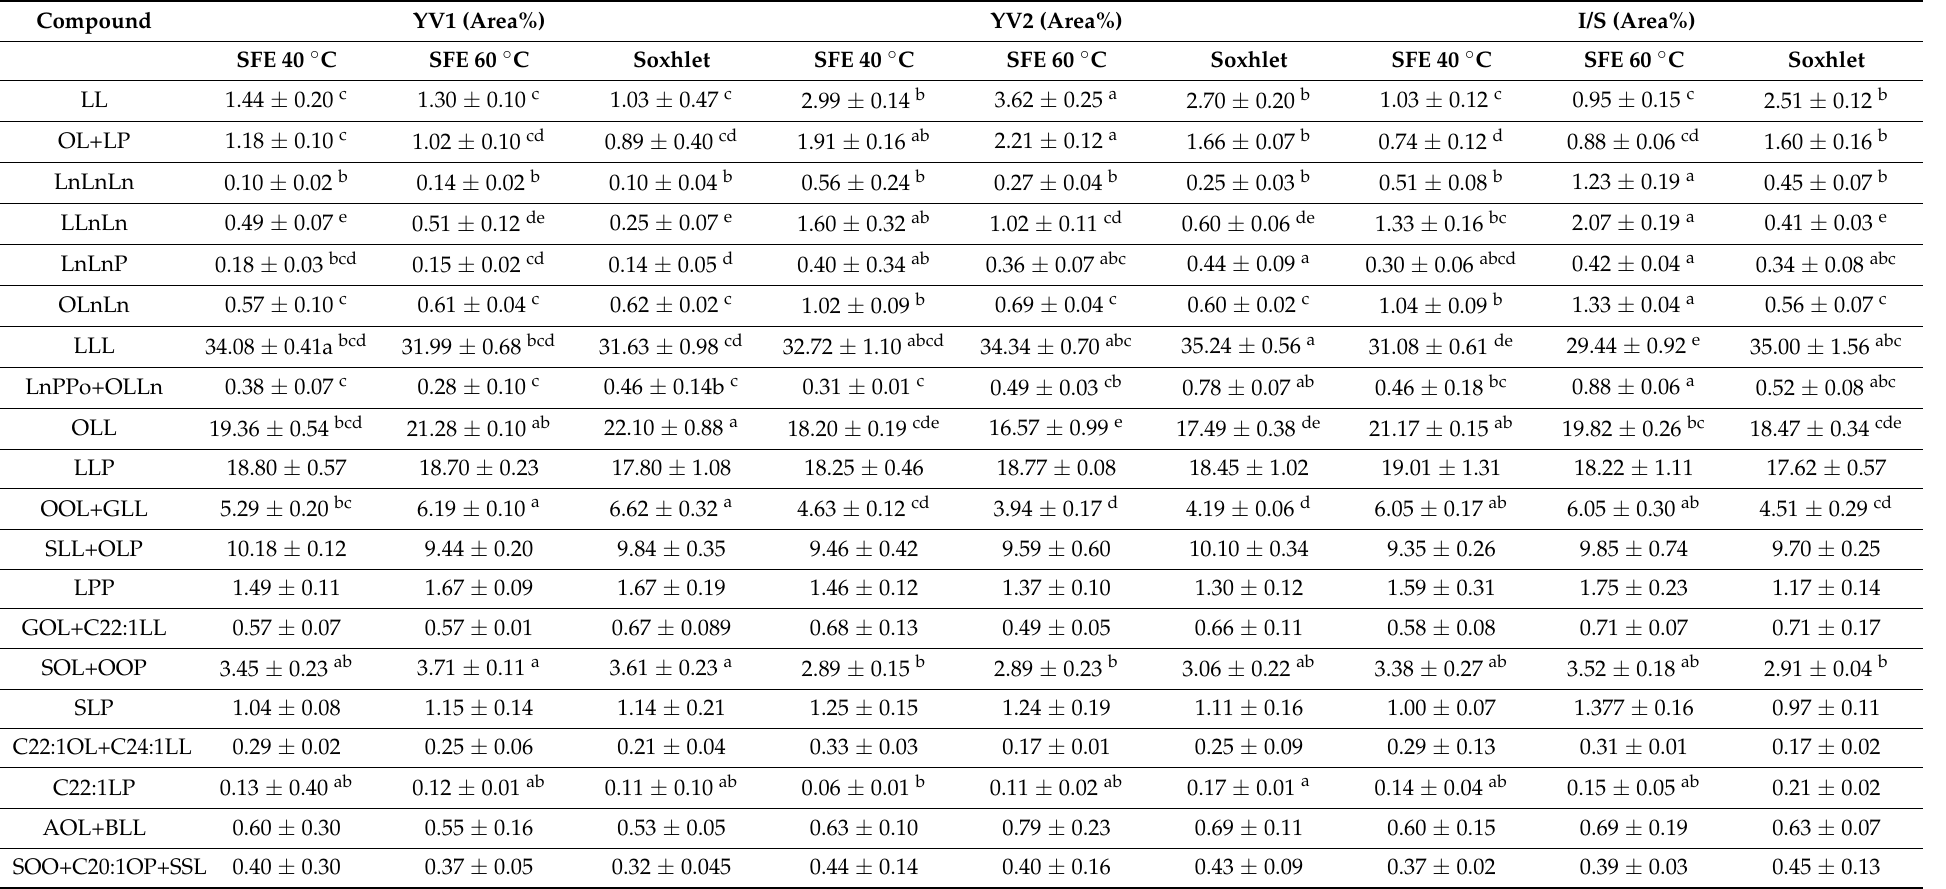
Mean values with different letters are significantly different, a–e at p < 0.01. Fatty acid legend: L = linoleic acid C18:2n6; O = oleic acid C18:1n9; P = palmitic acid C16:0; Ln = α -linolenic acid C18:3n3; Po = palmitoleic acid C16:1n7; S = stearic acid C18:0; A = arachidic acid C20:0; B = behenic acid